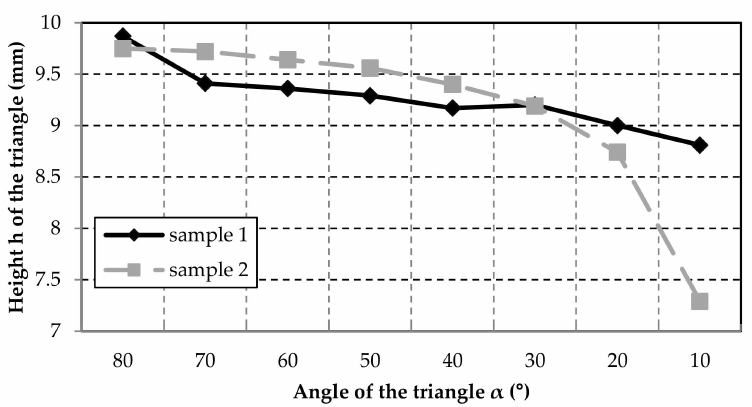
Figure 10. The deviations from the set point of the triangle angles of Sample 1 and Sample 2.